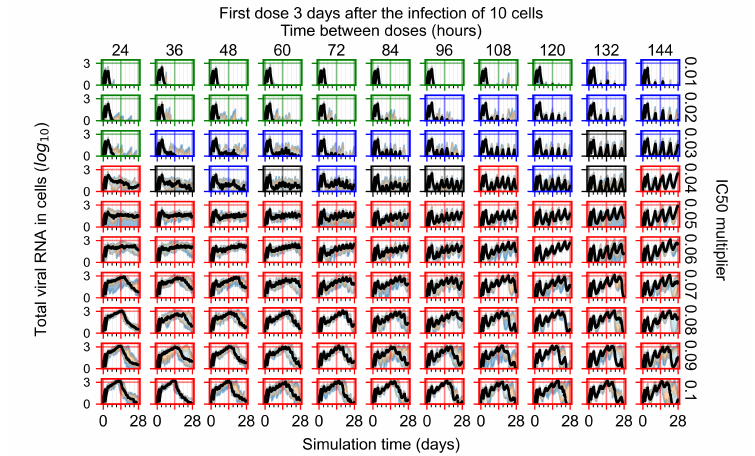
Figure A107. Amount of viral RNA in infected cells (arbitrary units), Y axis in log scale, and exponent values as tick marks.